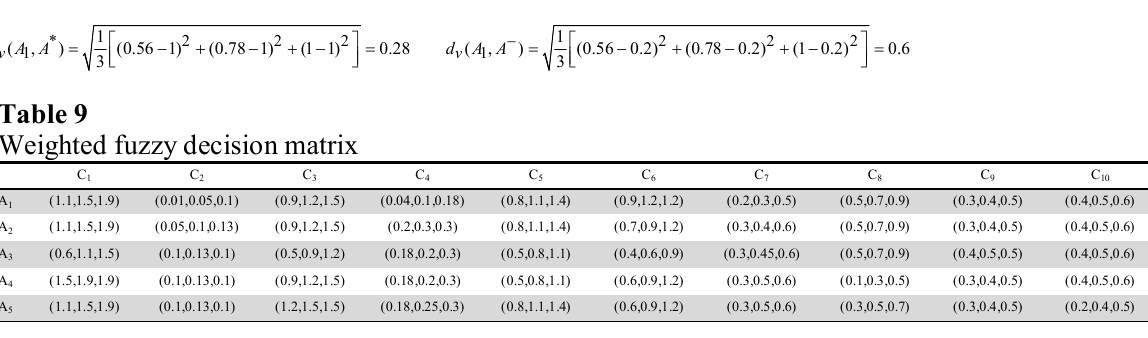
Table 11 and 12. In addition, the distances of each alternative from the FPIS and FNIS for the criteria C in front of alternative A includes 0.28 and 0.6, respectively. The equations for these quantities are as 4 5 follows;